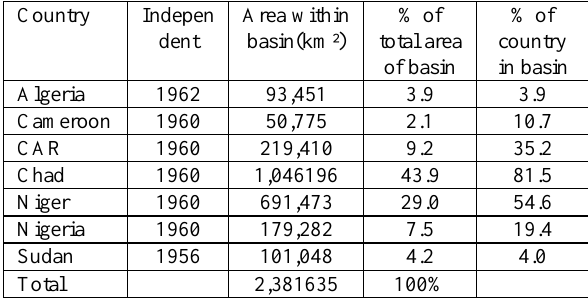
Table 2: Countries and percentage span Lake